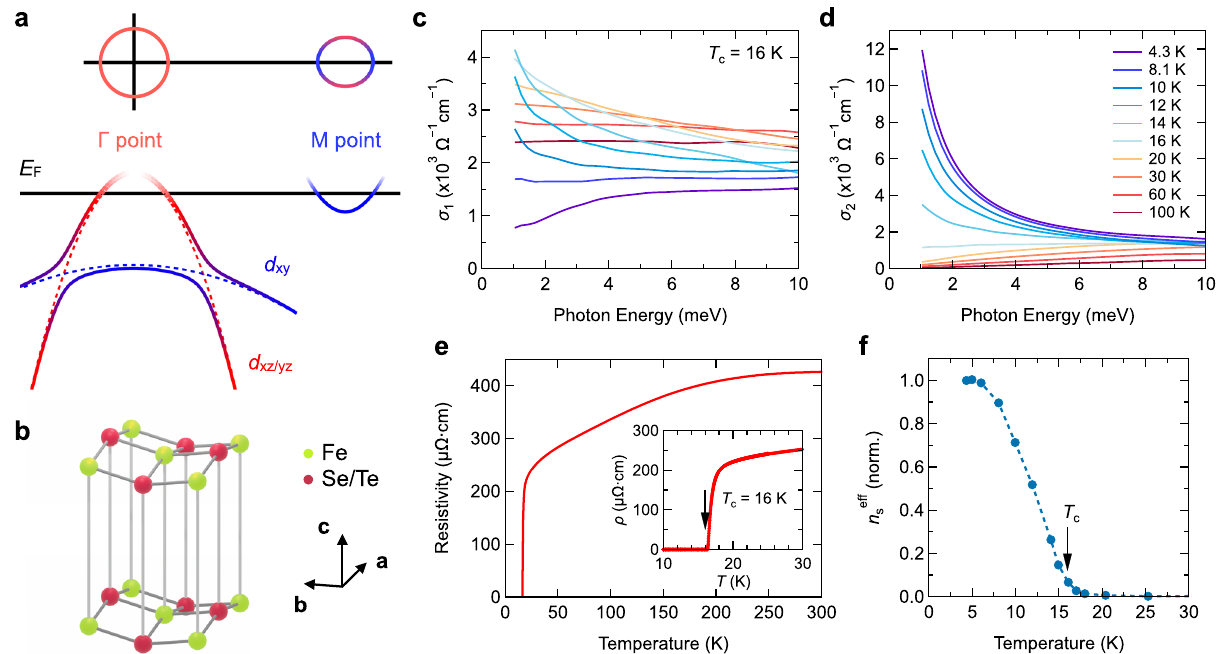
Fig. 1 Temperature dependence of optical conductivity and resistivity of a thin fi lm of FeSe 0.5 Te 0.5 . a Schematic illustration of the band structure of FeSe 0.5 Te 0.5 , consisting of the hole bands at around the zone center ( Γ point) and the electron bands at around the zone corner (M point) 30 . The iron d xz and d yz orbital characters are shown by red and the d xy orbital is shown by blue. A schematic of the Fermi surface is also drawn at the top. b Schematic illustration of the crystal structure of FeSe 0.5 Te 0.5 . The crystal axes are indicated by the black arrows. The thin fi lm sample of FeSe 0.5 Te 0.5 , oriented along the c -axis, was epitaxially grown on a CaF 2 substrate. c , d Optical conductivity spectra, ~ σ ω ð Þ ¼ σ indicated temperatures ( c : real part; and d : imaginary part). The superconducting transition temperature ( T c ) is 16 K. e DC resistivity as a function of the temperature. Inset shows magni fi ed data around T c , de fi ned by the zero resistivity. f Temperature dependence of the super fl uid density, n eff the low-energy region of σ 2 ω ð Þ ( _ ω < 2 meV). The dashed line is a guide to the eye. The de fi nition of n eff